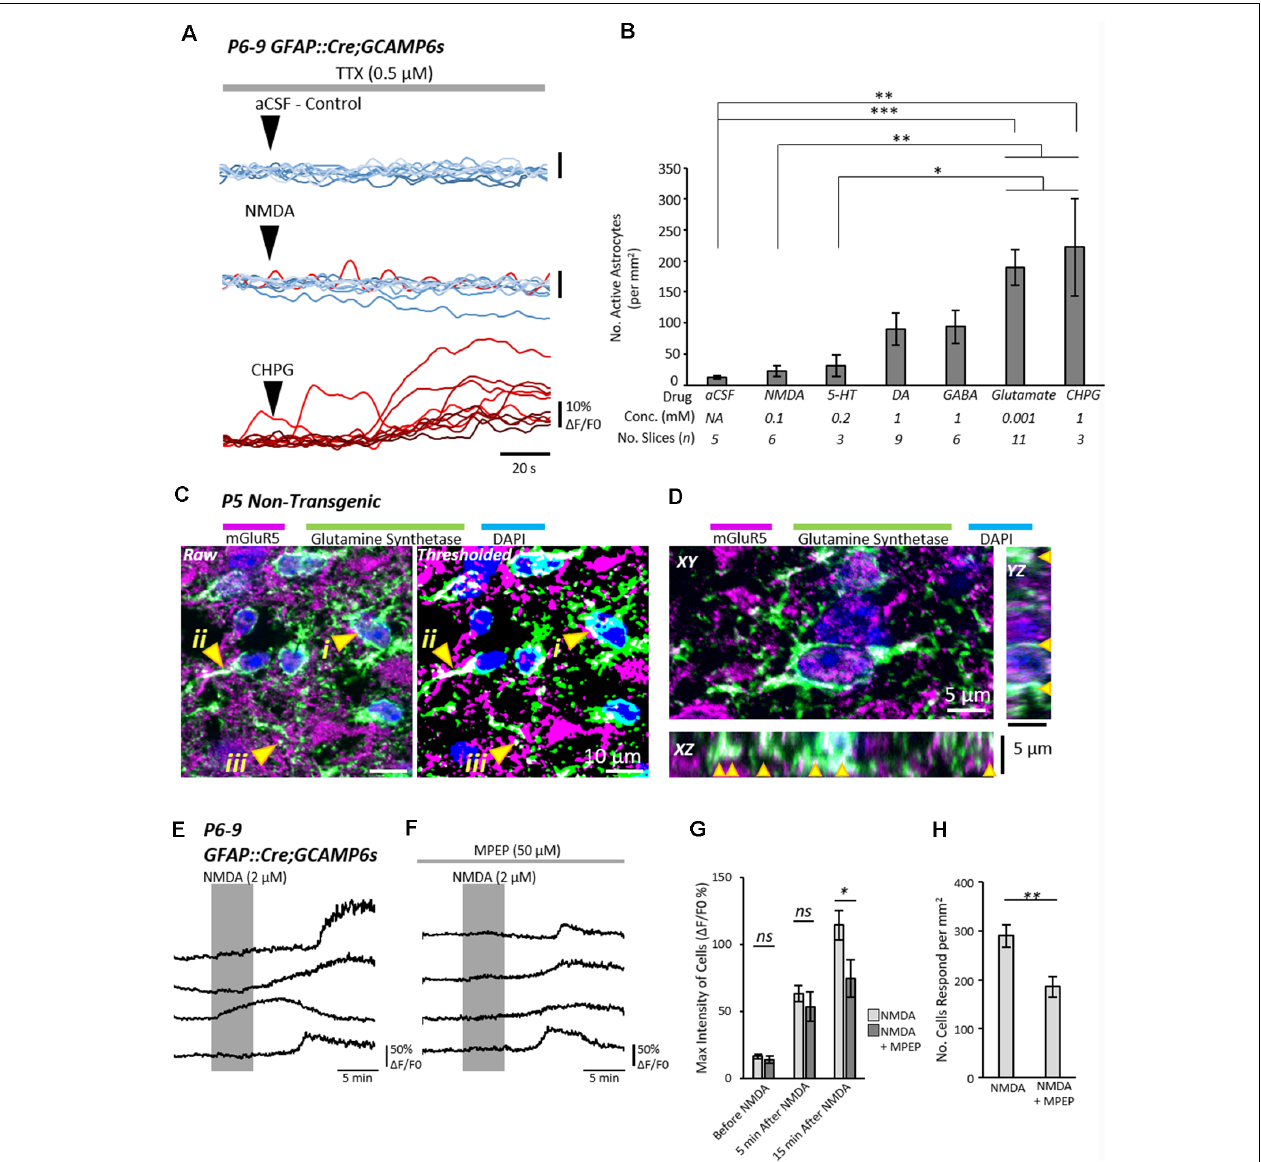
FIGURE 2 | Astrocytic metabotropic glutamate receptor 5 (mGluR5) receptors mediate neuronal-to-astrocyte signaling in the mammalian spinal cord. (A) Example traces from Ca 2+ imaging of astrocytes during local applications of vehicle control artificial cerebrospinal fluid (aCSF), N-methyl-D-aspartate (NMDA) and (RS)-2-Chloro-5-hydroxyphenylglycine (CHPG) in the presence of TTX (1 µ M). Traces from 10 cells from within the same experiment are shown for each agonist overlayed. Traces are displayed in a red-hue if responsive to the drug, and blue if non-responsive. (B) Bar chart displaying the density of astrocytes that responded to a given pharmacological stimulus. The agonist concentrations and the number of slices ( n number) for each agent are listed below the graph. (C) Visualization of mGluR5 receptor expression in glutamine synthetase-labeled astrocytic cell bodies (i), primary leaflet/processes (ii) and finer processes (iii). (D) 3D visualization of mGluR5 localization on astrocytes with orthogonal views of XY, XZ and YZ. Arrows denote cases of colocalization between mGluR5 and glutamine synthetase observed in 3D. (E) Application of NMDA in spinal cord slices from GFAP::Cre;GCAMP6s mice enables the visualization of astrocyte activity in response to neuronal activation. NMDA does not activate astrocytes directly (see Figure 3 ). (F) Application of NMDA in the presence of mGluR5 antagonist Methyl-6-(phenylethynyl)pyridine hydrochloride (MPEP) shows attenuated responses from astrocytes. (G) Bar chart showing that the degree of astrocytic activation 15 min after NMDA application was significantly reduced when slices were incubated in the mGluR5 antagonist, MPEP. (H) Bar chart showing the number of astrocytes that responded to neuronal activity induced by NMDA was reduced in the presence of MPEP. ∗ p < 0.05, ∗∗ p < 0.01, ∗∗∗ p < 0.001; ns, not